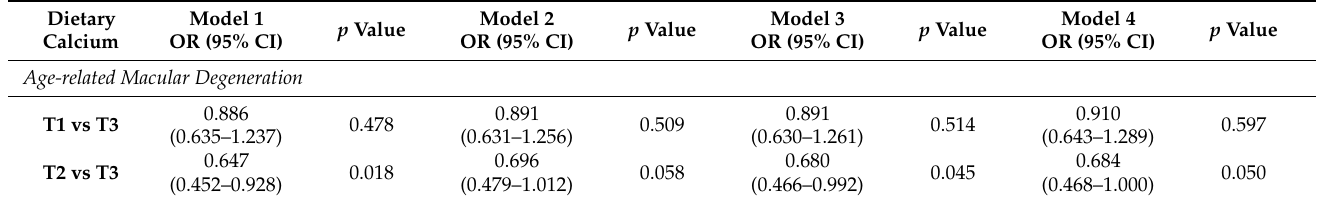
Table 4. Association between tertiles of dietary calcium and the presence of age-related macular